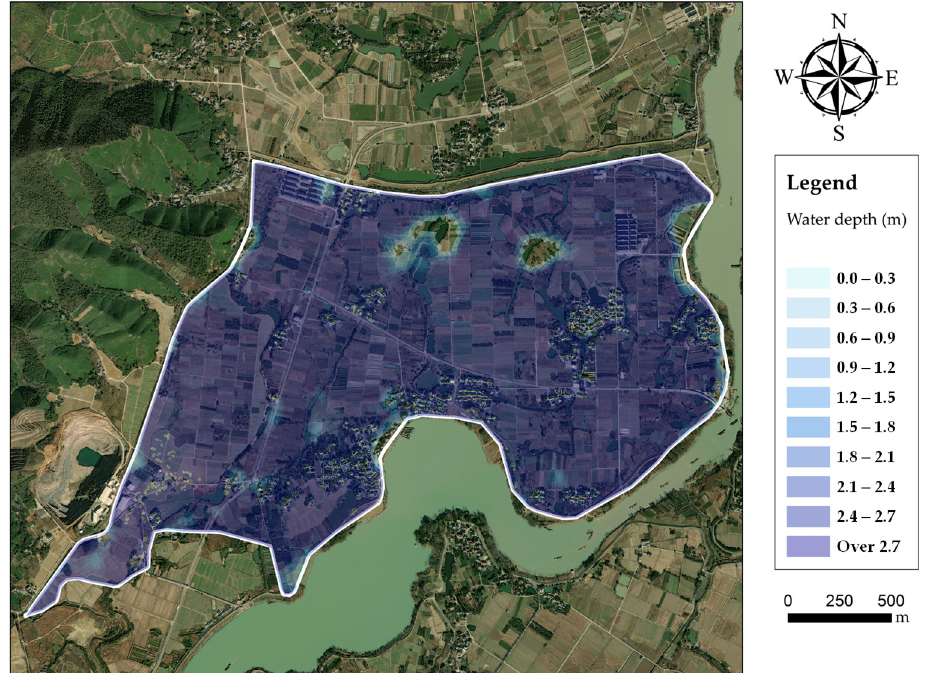
Figure 10. Inundated areas in flood scenario of 100-year return period.